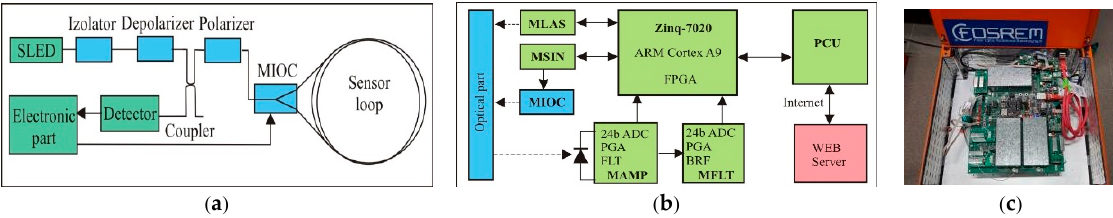
Figure 1. General construction of FORS: ( a ) block diagram of optical part, ( b ) block diagram of electronic part, ( c ) technical realization for FORS-2.